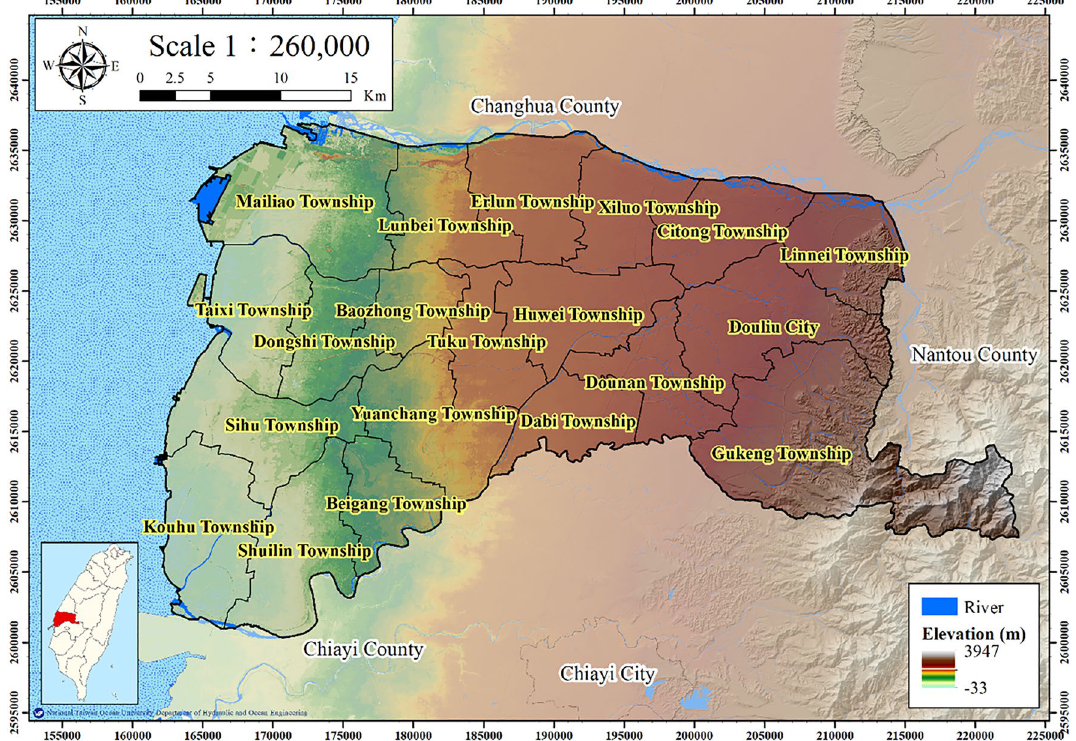
Figure 1. Topography of Yunlin County. This figure was created using ArcGIS 10.6.1 software.